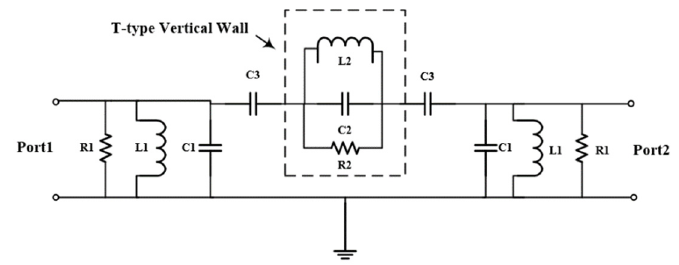
Figure 12. The equivalent circuit for the proposed structure.